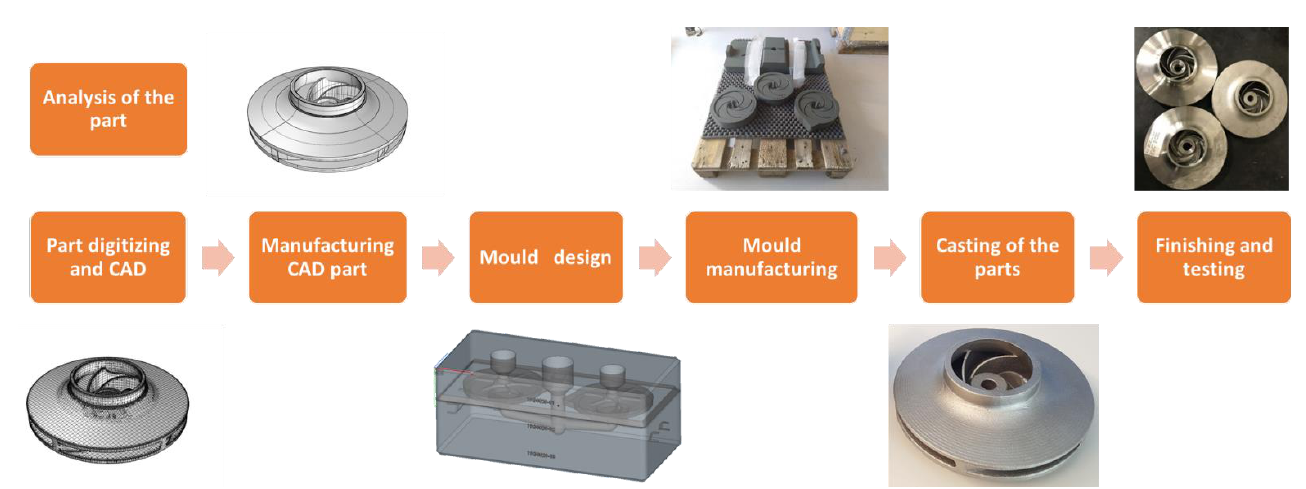
Figure 4. Workflow employed for the fabrication of the BJ impeller.